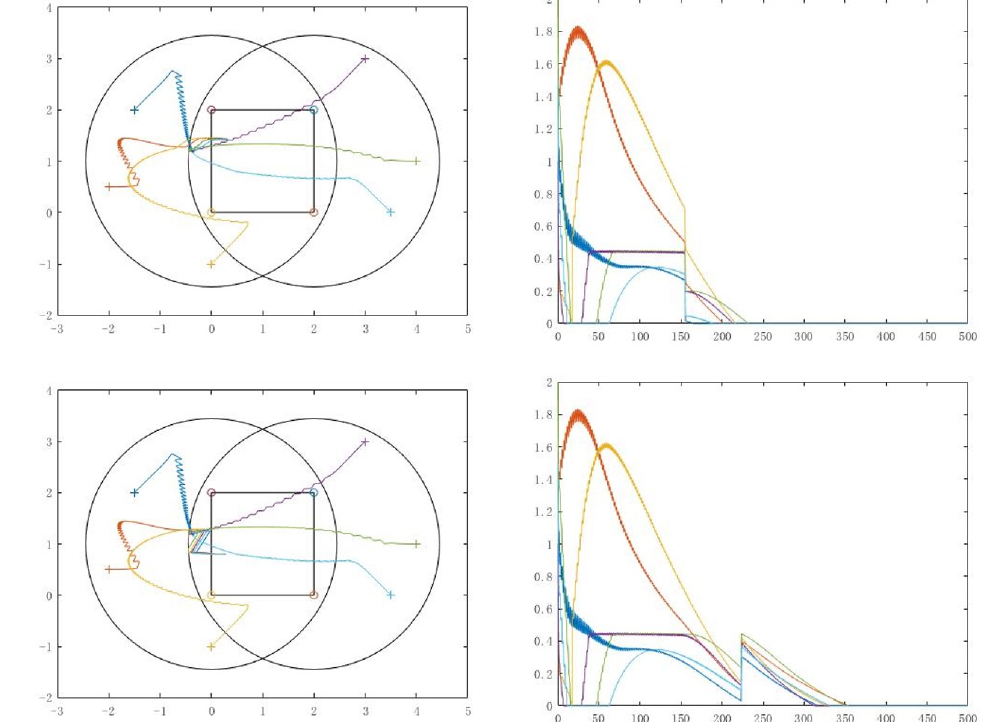
Figure 8. Position states and containment errors with interference.